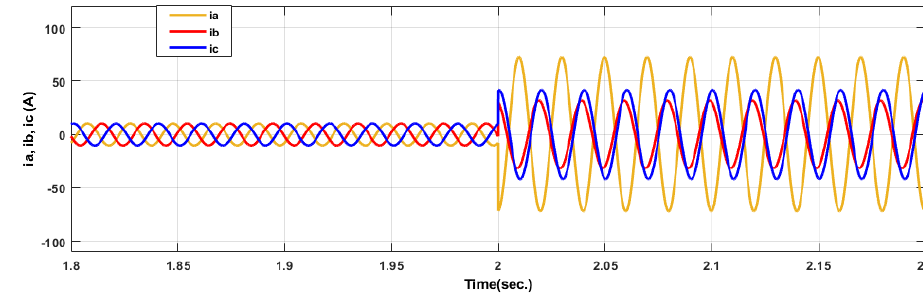
Figure 34. Current signals for 25% short circuit fault in phase a.